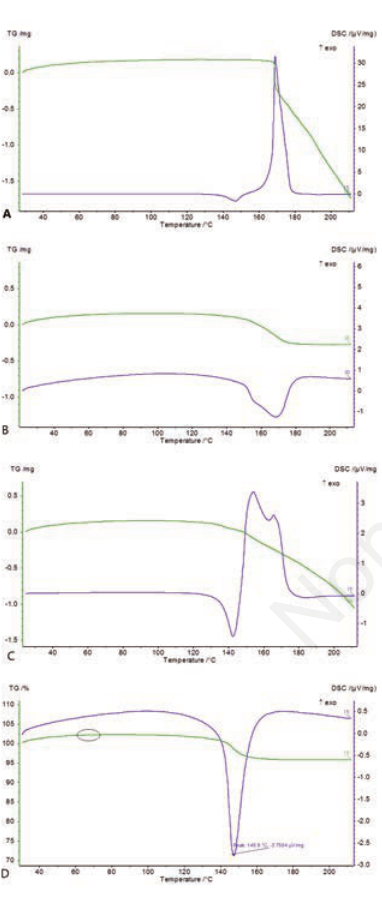
Figure 6. DSC thermogram of (A) AS; (B) AQ; (C) physical mixture AS-AQ (ekimo- lar); (D) AS-AQ